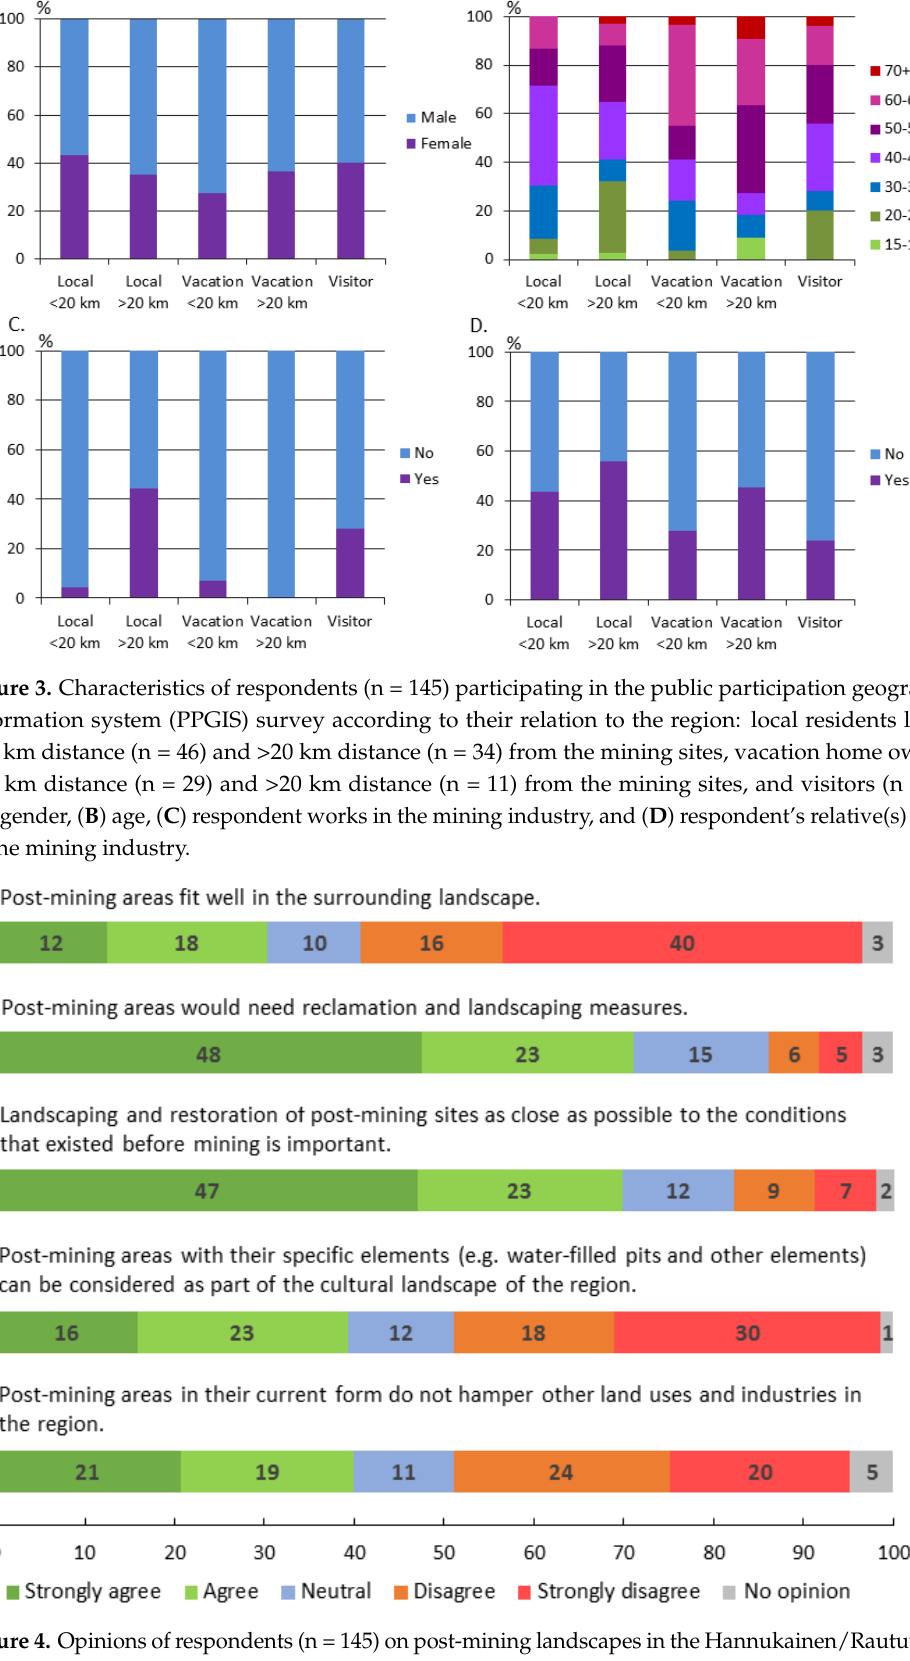
Figure 4. Opinions of respondents (n = 145) on post-mining landscapes in the Hannukainen/Rautuvaara region. Table 2. Chi-square statistics for respond ents’ opinions on statements related to post-mining landscapes in the Hannukainen/Rautuvaara region. See Figure 4 for full statements. Relationships between opinions (agree/disagree) and gender, age, relationship to the region, respondent’s work in the mining industry, and respondent’s relative(s) work in the mining industry were examined.